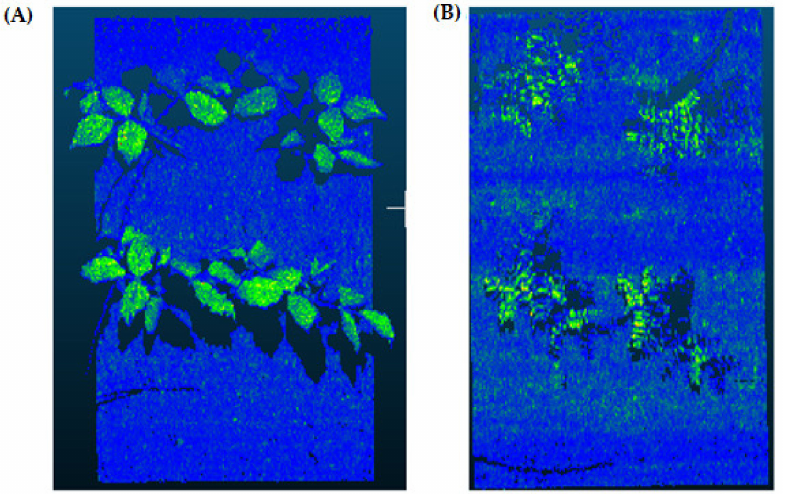
Figure 3. Outputs of tray segmentation process for mung bean ( A ) and chickpea ( B ) files. This operation is the first step of the background cleaning process and is carried out according to the fixed tray dimensions and coordinate information. As a result of this operation, the tray data are completely cleared from the raw